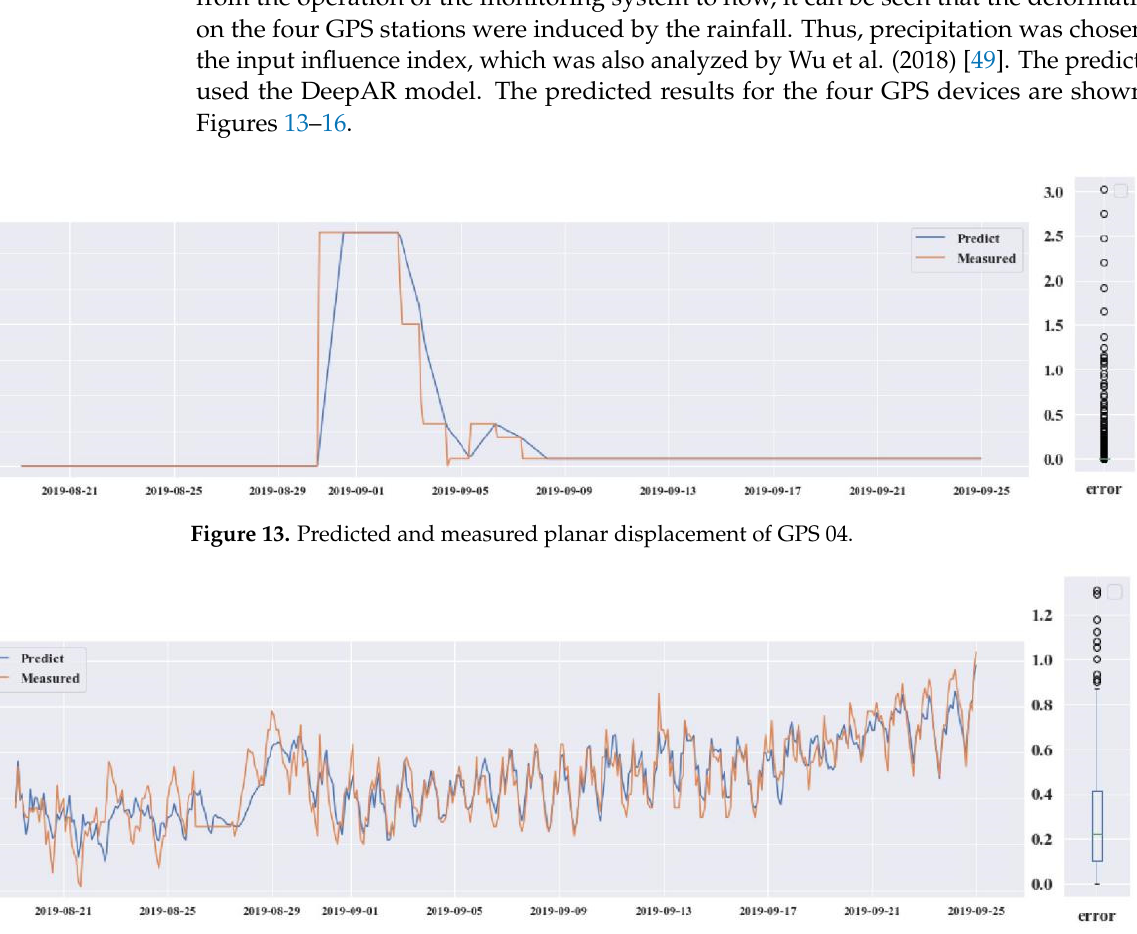
Figure 14. Predicted and measured planar displacement of GPS 06.